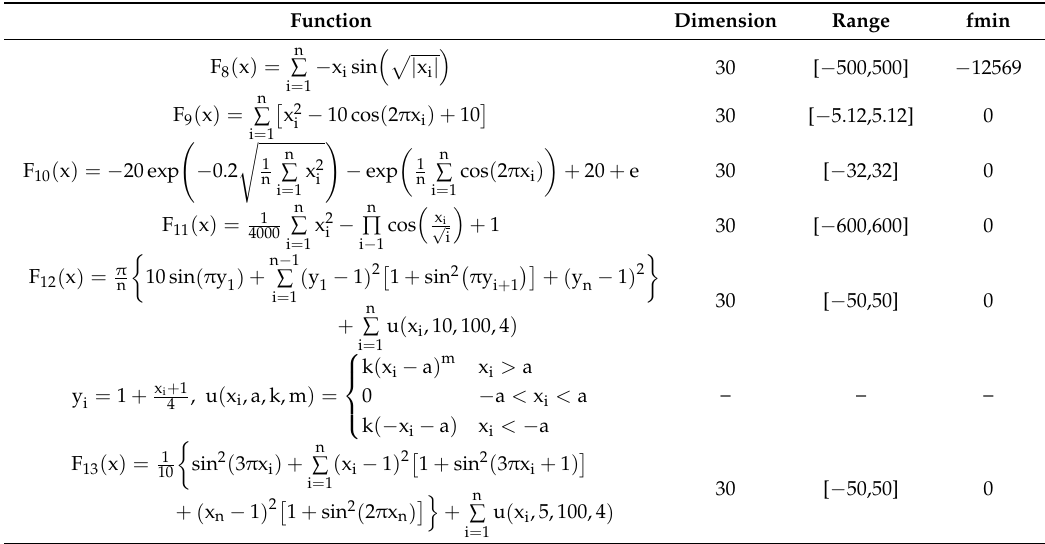
Table 3. Multimodal test functions with dimensions =